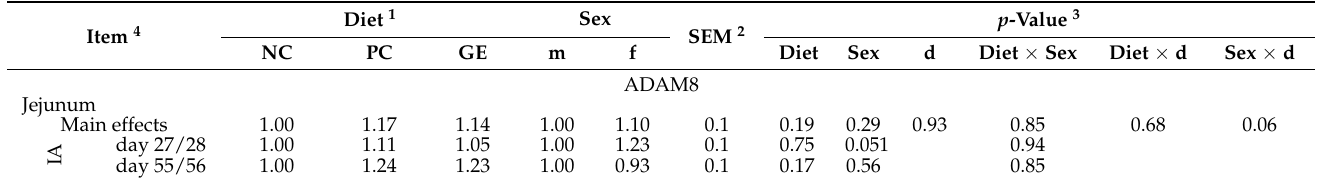
Table 8. Expression of selected marker genes involved in tissue remodelling and immune activation in the intestinal tissue of weaning piglets fed GE compared to NC and PC. NC was set to